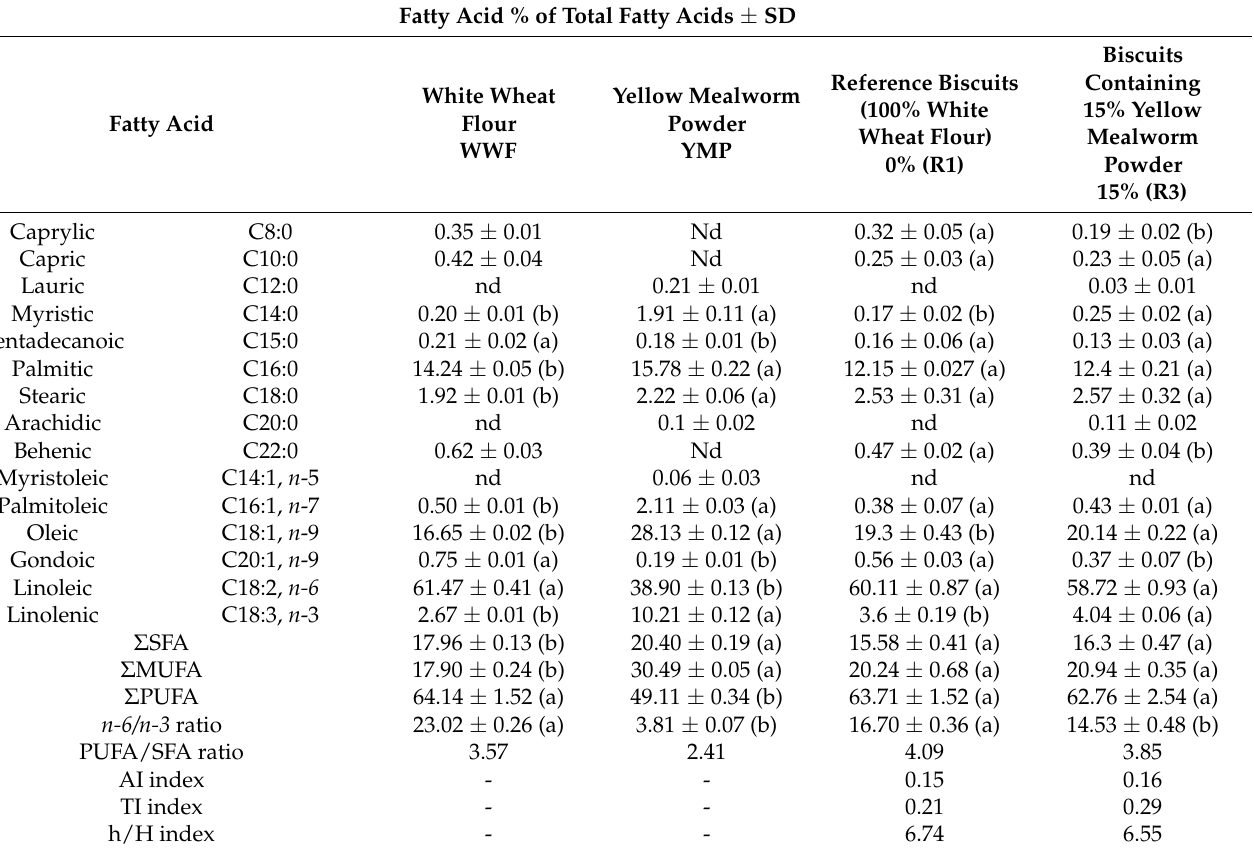
Table 3. Fatty acids profiles in white wheat flour (WWF), yellow mealworm powder (YMP), and selected